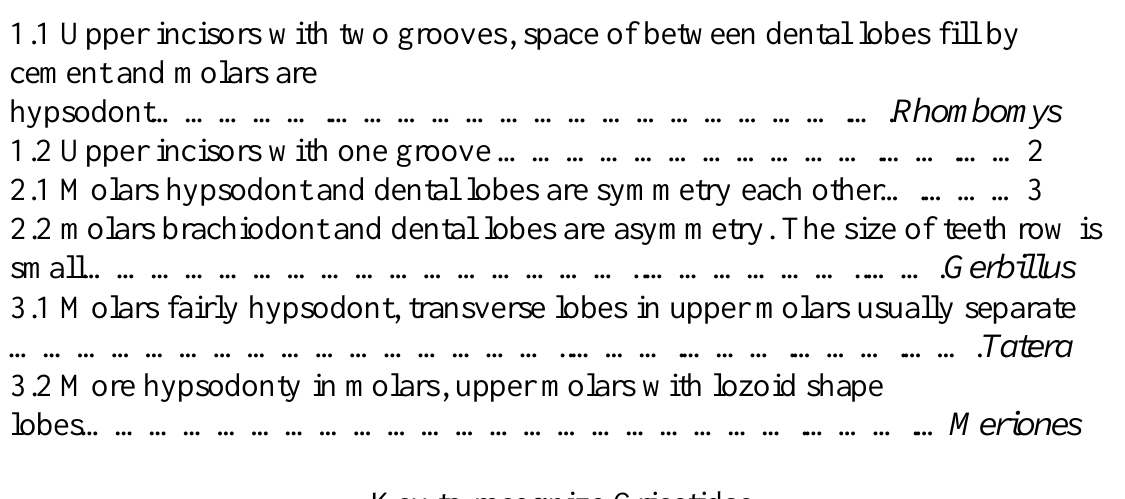
Key to recognize